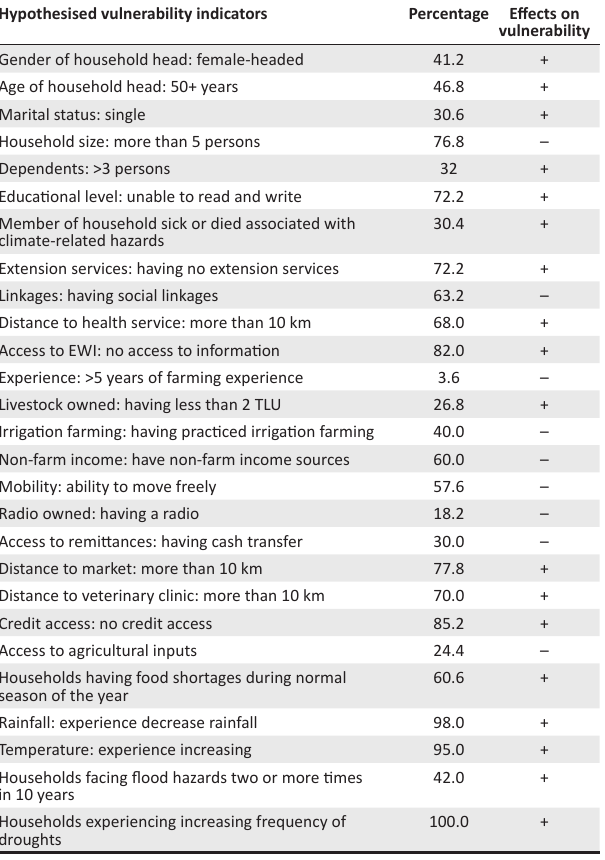
TABLE 2: Selected vulnerability indicators and their effects on vulnerability. Hypothesised vulnerability indicators Percentage Effects on